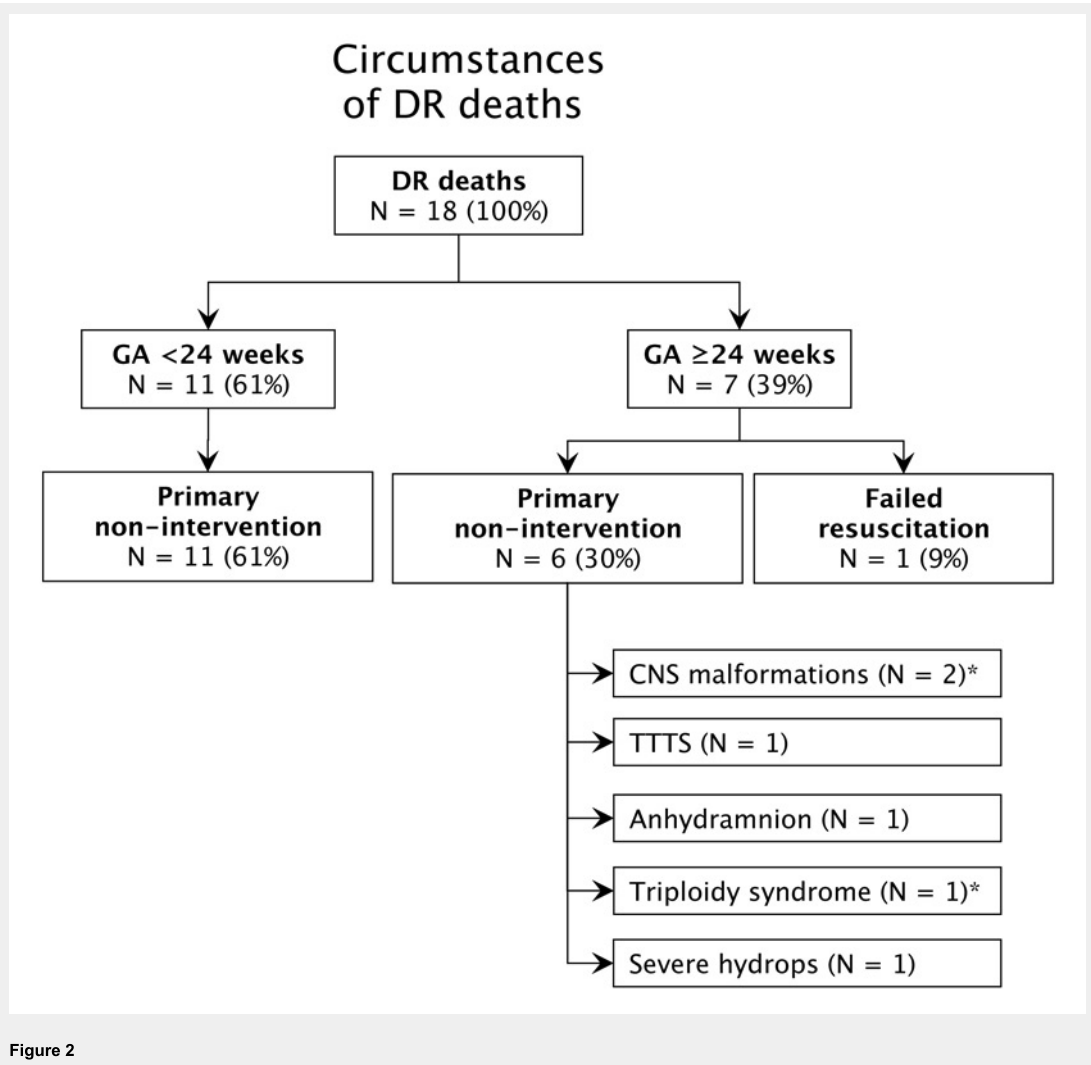
Figure 2 Circumstances of death in ELGANs who died in the DR. CNS = central nervous system; TTTS = twin-to-twin transfusion syndrome. * Late termination of